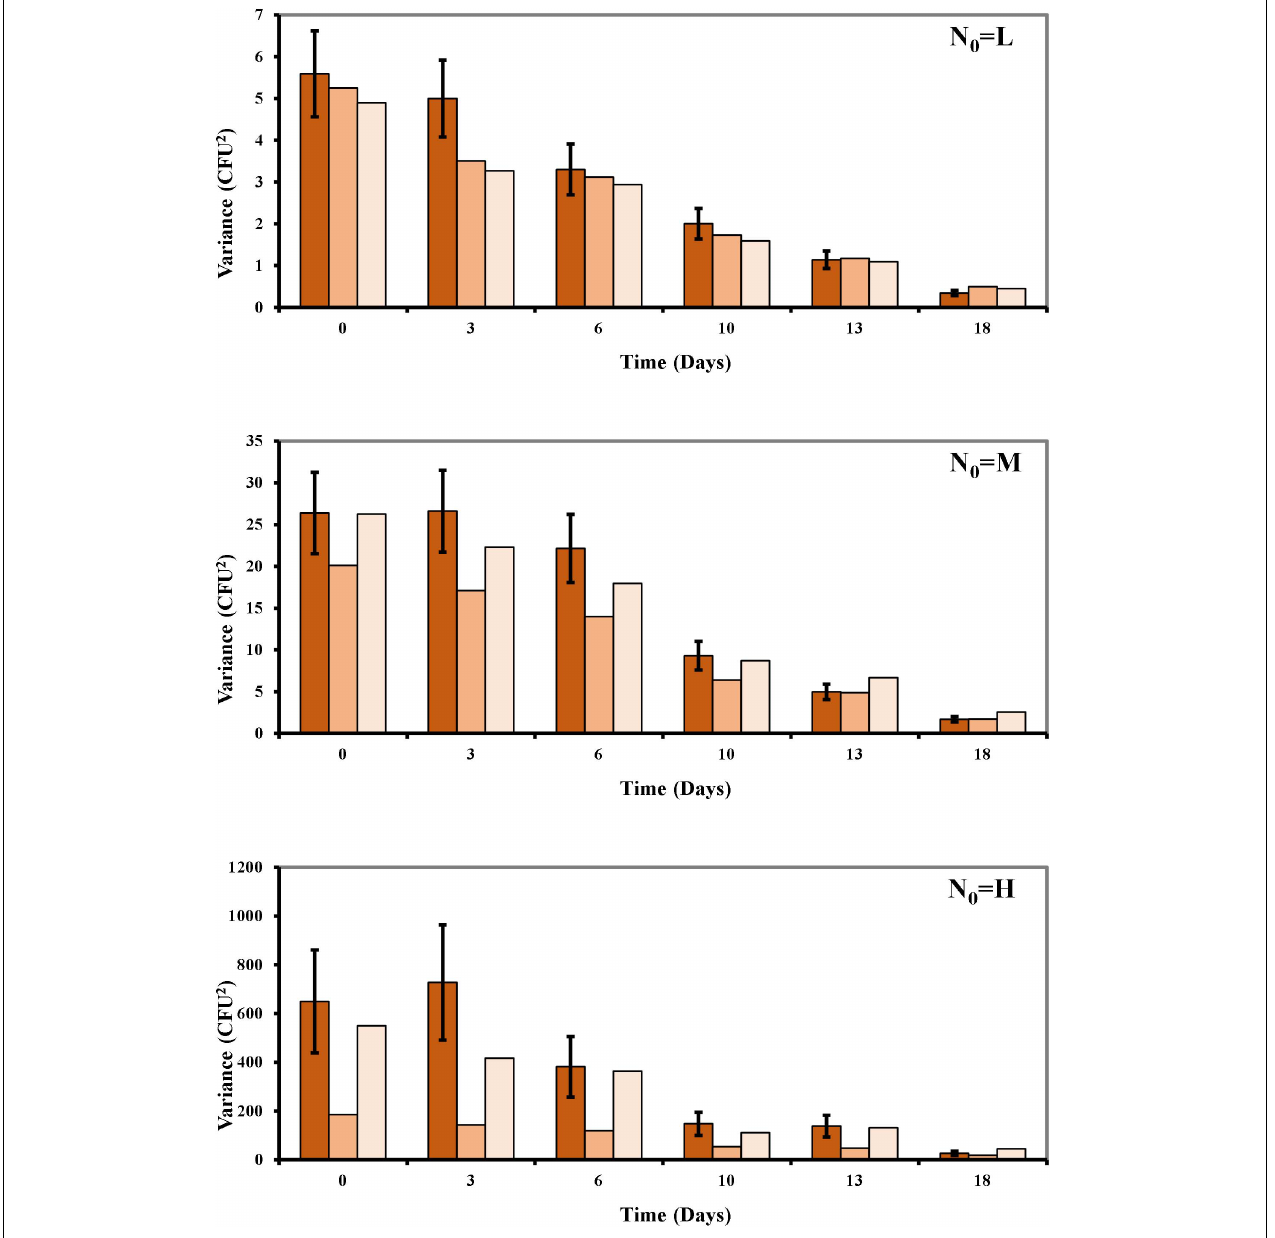
FIGURE 3 | Mean of the variances over time of the observed survival Listeria data compared to the Poisson and the COM-Poisson ( Supplementary Box 1 ) distributions fitted to the experimental data points at the different N 0 (L, low inoculum; M, medium inoculum; H, high inoculum). Observed variances: dark orange columns; Poisson distribution variances: orange columns; COM-Poisson distribution variances: light orange columns; bars are standard